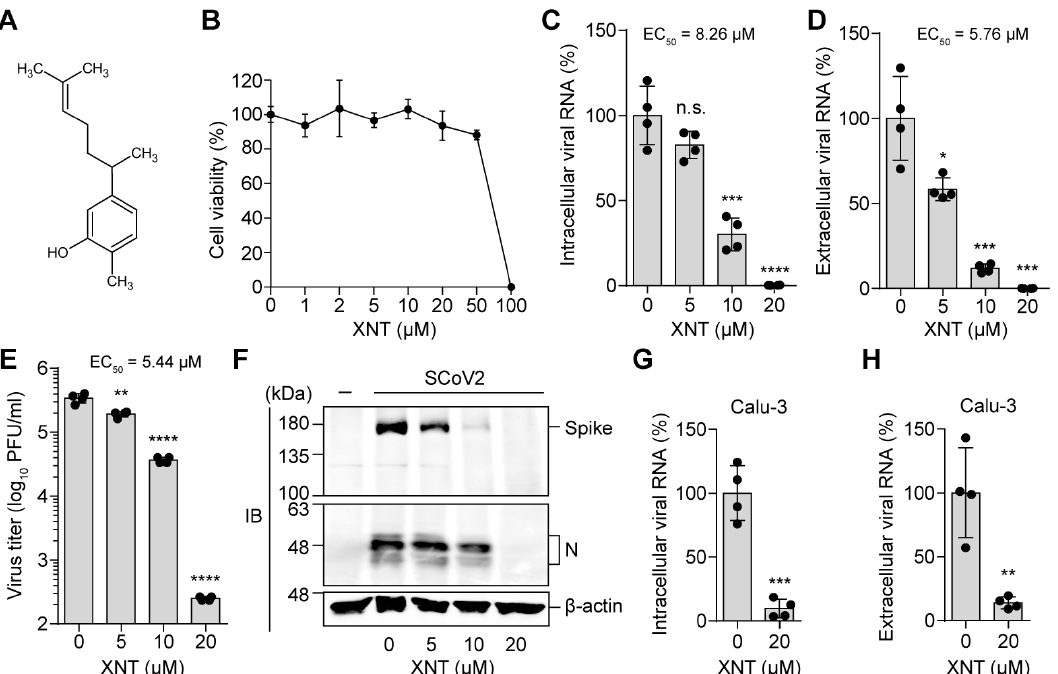
Figure 1. Antiviral activity of XNT against SCoV2. ( A ) Chemical structure of XNT. ( B ) Cytotoxicity of XNT, assessed by MTS assay 24 h after treatment of Vero E6 cells with increasing concentrations of XNT. The experiments were performed in biological triplicates. ( C – F ) Intracellular viral RNA ( C ), extracellular viral RNA ( D ), and infectious virus ( E ) titers, determined 24 h after treatment of SCoV2 (KCDC03)-infected Vero E6 cells (MOI = 0.01) with XNT. ( F ) shows the immunoblots for the indicated viral proteins in XNT-treated cells. ( G , H ) Antiviral activity of XNT in Calu-3 cells, assessed as described above. In ( C – H ), bar graphs show the mean ± SD with data points (two from each set) from two biological replicates. * p < 0.05; ** p < 0.01; *** p < 0.001; **** p < 0.0001; n.s., not significant; by unpaired two-tailed Student’s t -test.